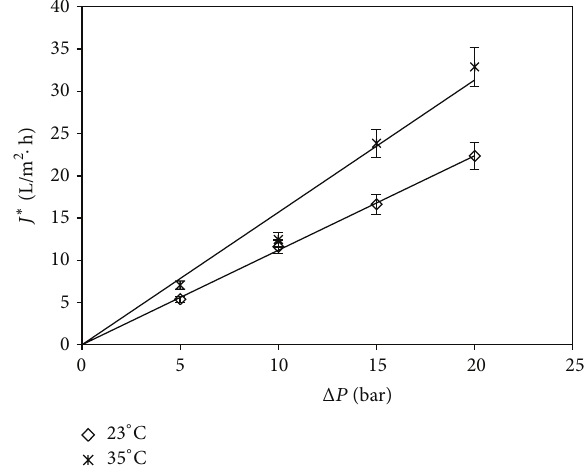
Figure 2: Effect of transmembrane on ethanol permeate flux ( 𝐽 ∗ ) to 23 and 35 ∘